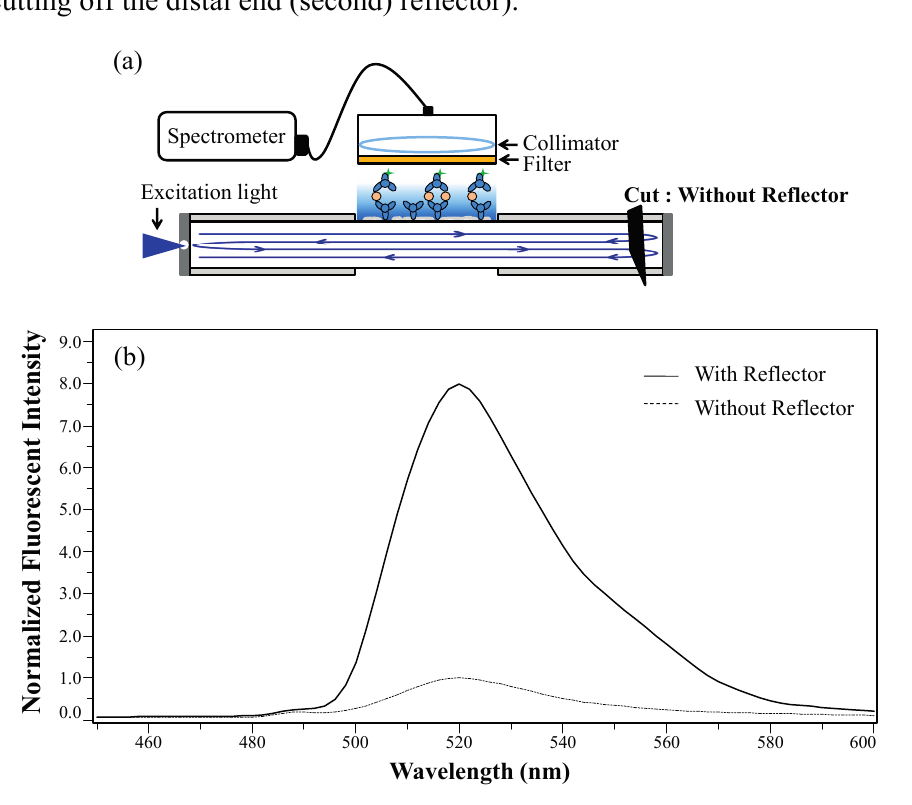
Figure 5. ( a ) Biosensor structure with direct reflective coating of Ag/Al reflector on the end-faces. The second reflector was cut off to demonstrate the termination of the resonance condition “without reflector”; ( b ) Normalized fluorescent intensity spectrum with reflector (solid line) and without reflector (dashed